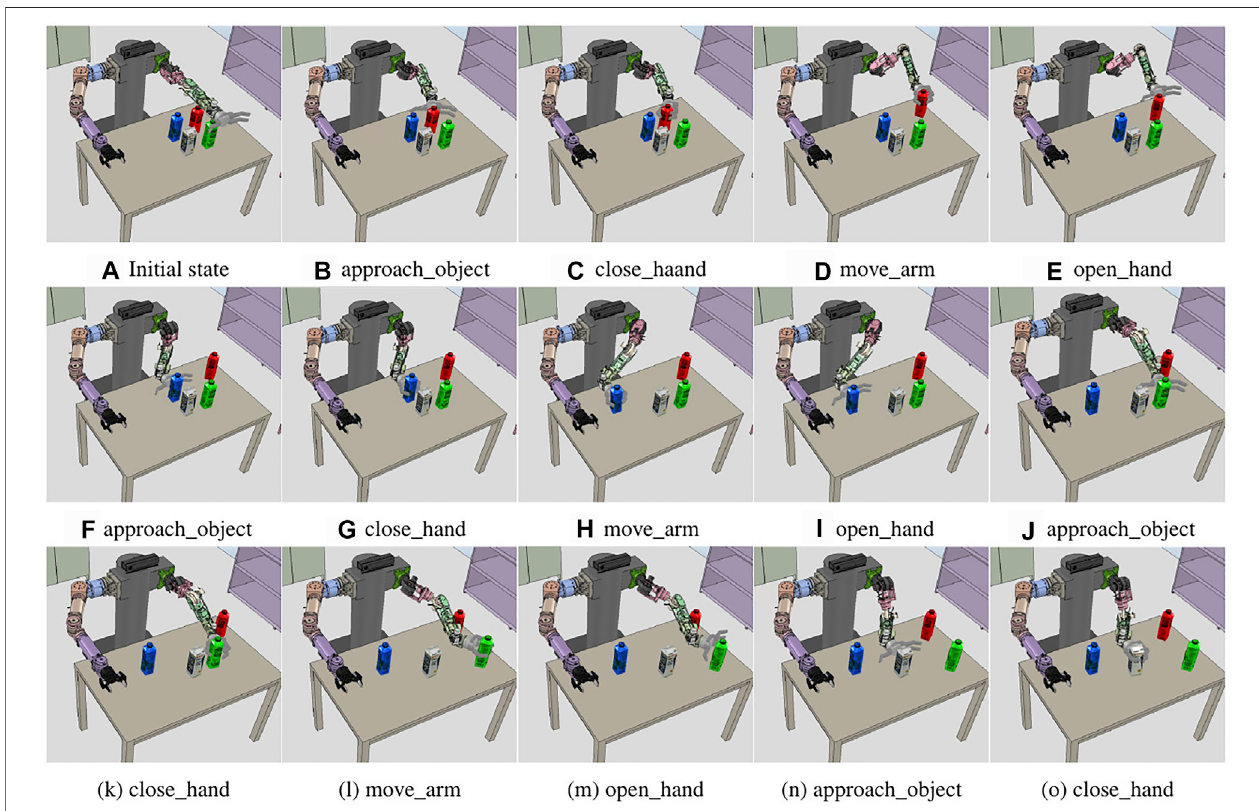
FIGURE 11 | Sequence of the execution snapshot for the obstructed milk box picking problem. (A) Initial state of the experiment. left _ hand , right _ hand , obj _ milk , obj _ redjuice , obj _ bluejuice , and obj _ greenjuice are recognized. (B – O) show the results of performing each primitive action.